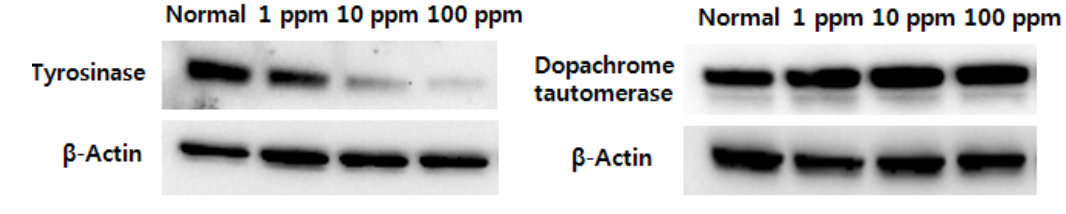
Figure 3. Effects of corn silk extract on the expression of tyrosinase and dopachrome tautomerase